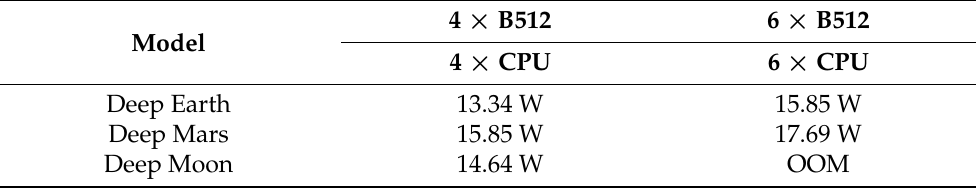
Table 18. The peak power consumption during benchmarks for B512 DPU architecture.